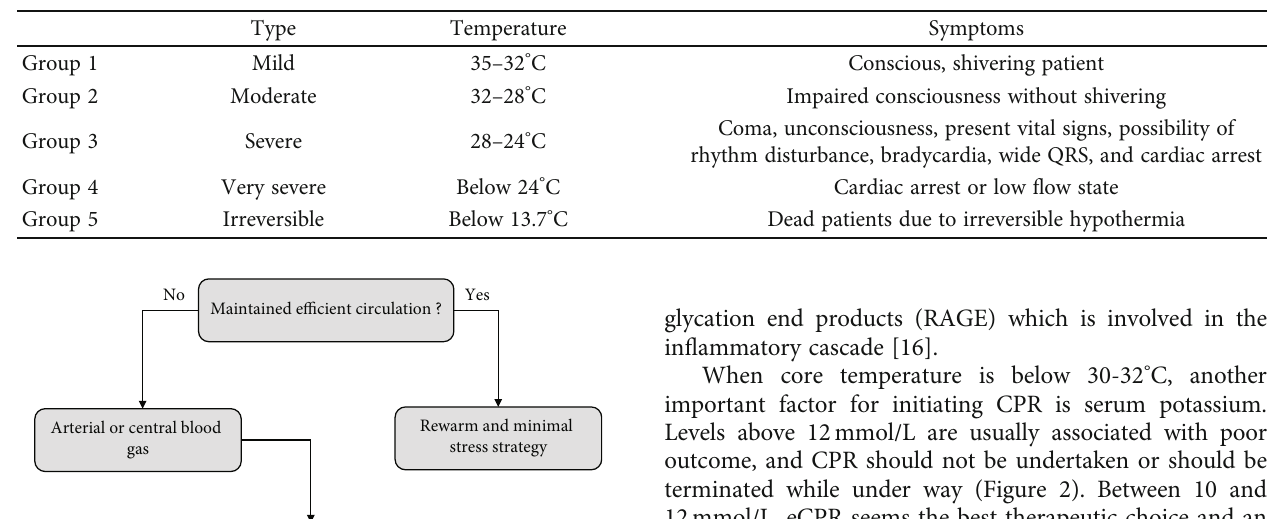
Figure 1: First 4-hour temperature trends in patients 1 and 2. Table 1: Groups of hypothermia according to its severity [6].